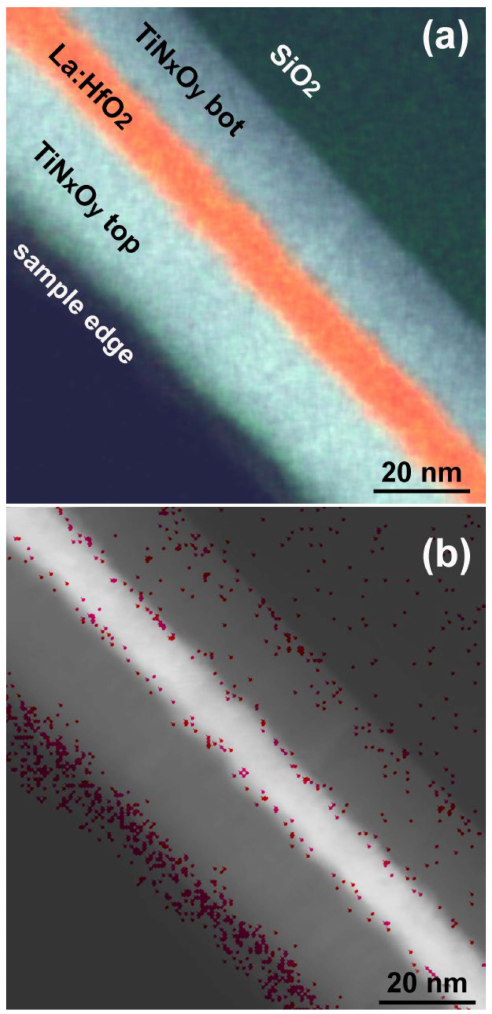
Figure 3. Image overlay of N, O, Si, Ti and Hf element map ( a ), HAADF STEM image with superim- posed two-phase maps containing a maximum of Ti and O ( b